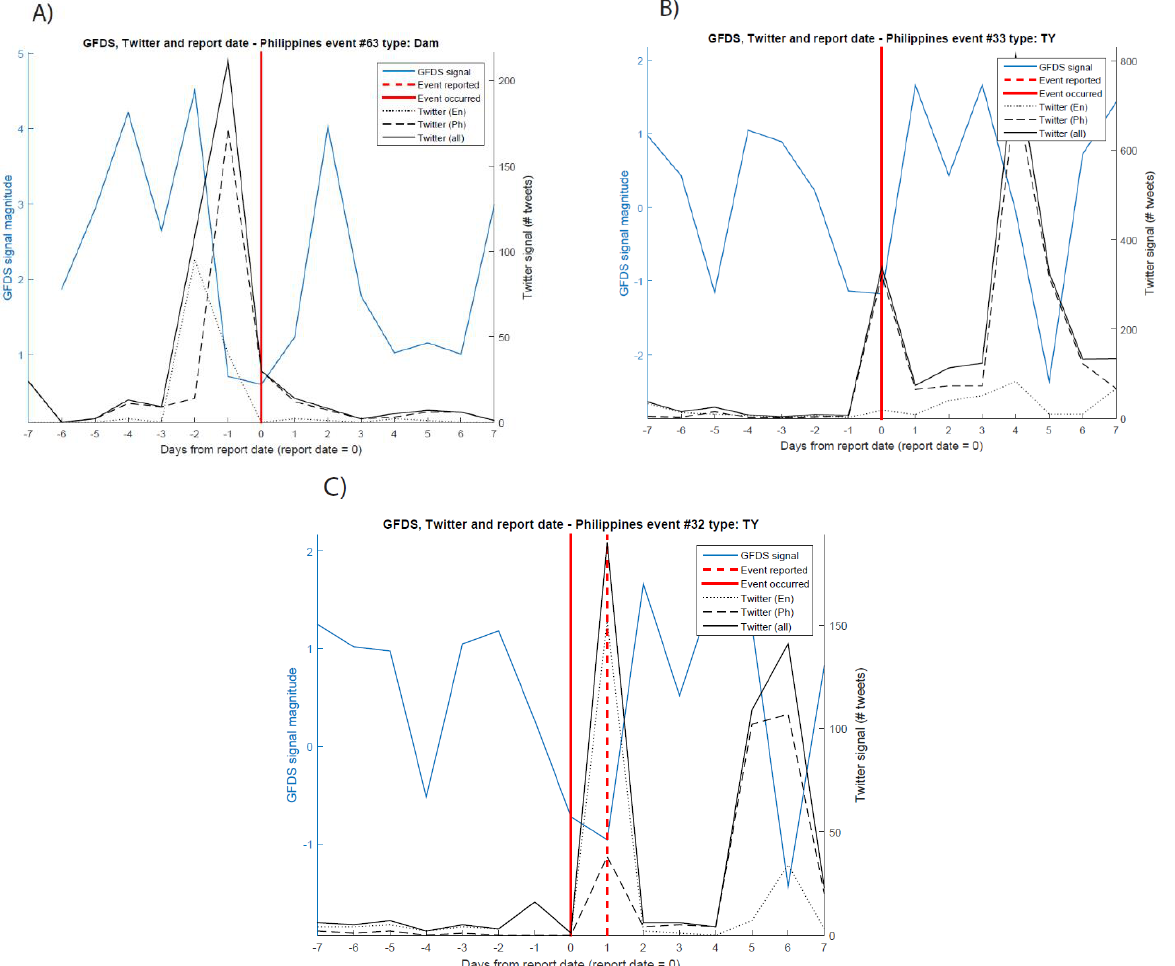
Figure 3. Flood signal from GFDS (blue line) and Twitter analysis (black lines for tweets in English language (fine dash); Filipino language (coarse dash); and both languages (solid line). The red lines indicate when the event occurred (solid) and was reported (dashed). If only one red line is shown, the dates of occurrence and reporting are the same. Flood types refer to dam break (“Dam”) and typhoon (“TY”). The individual graphs are for different events that occurred throughout 2014, including ( A ) one dam overtopping and ( B , C ).two typhoon-triggered river